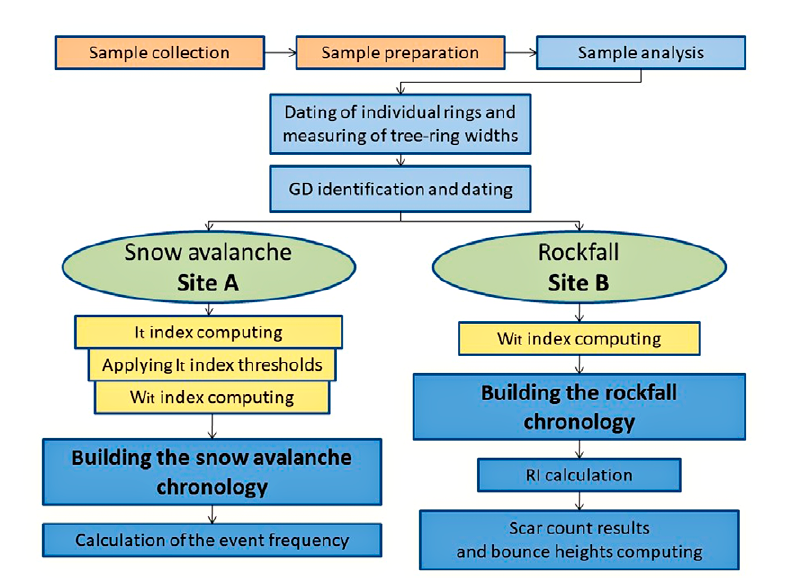
Figure 4. Methodological steps used for each of the investigates